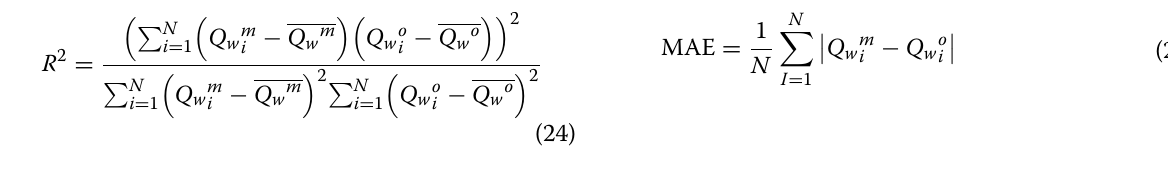
Max, maximum; Min, minimum; Avg, average; SD, standard deviation; and R, correlation